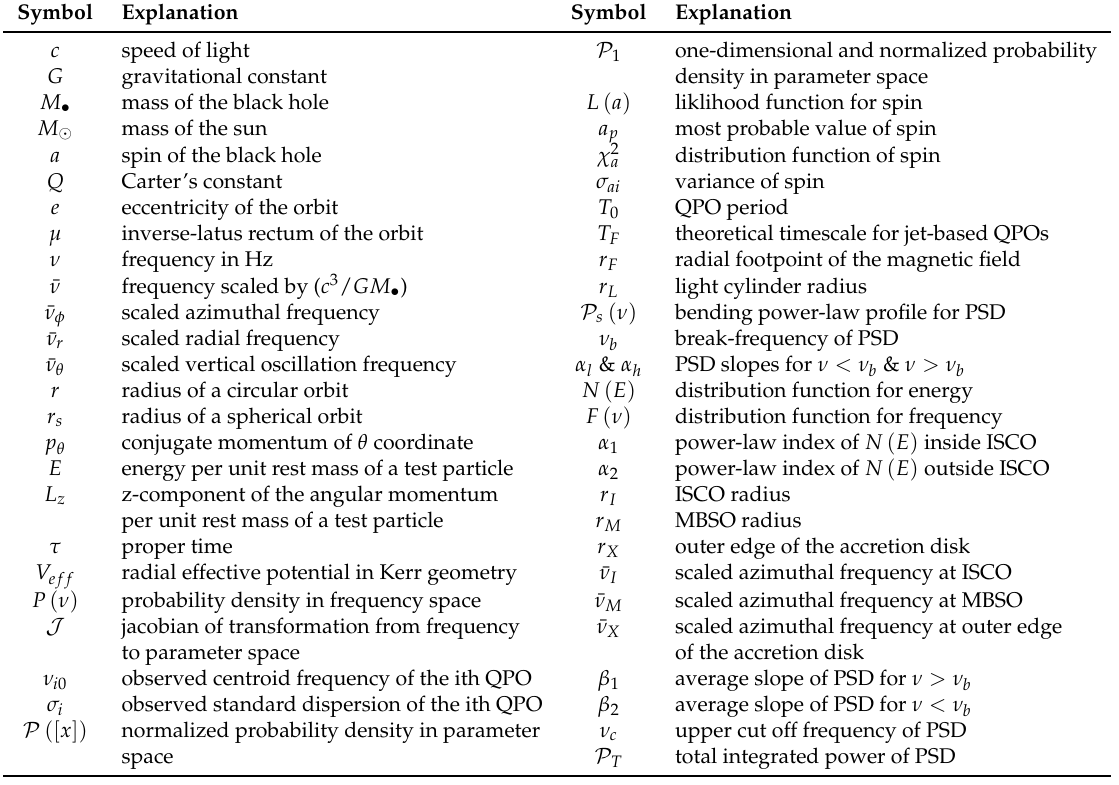
Table 1. A glossary of symbols